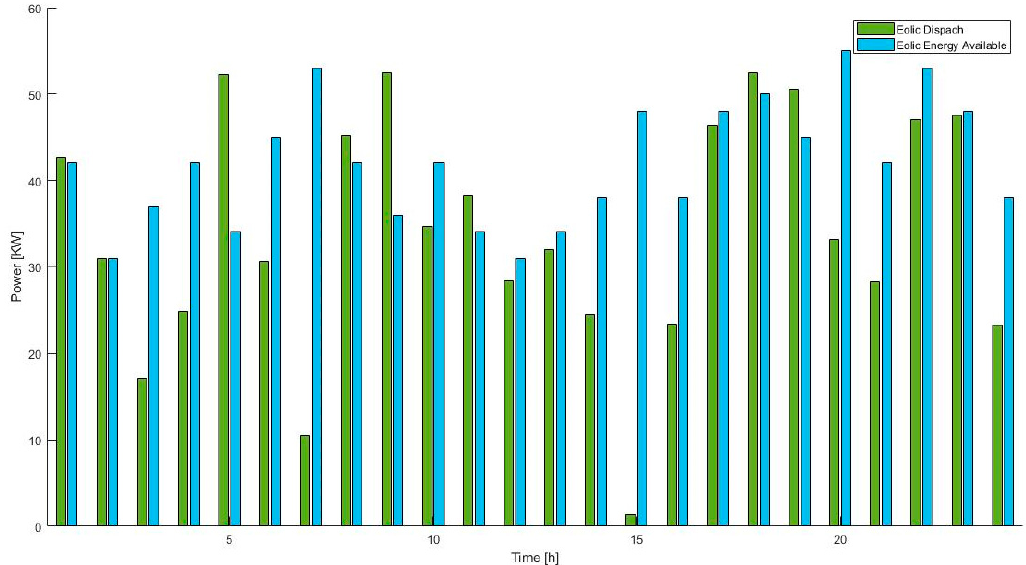
Figure 10. Availability and dispatch of the wind energy system of the MG when the storage system is at 30% of its useful life.